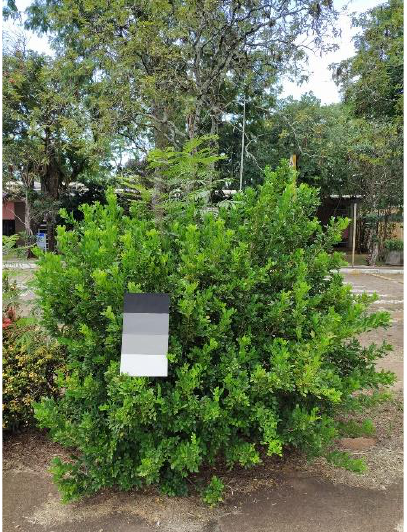
Figure 3 . Grey scale panel and the vegetation